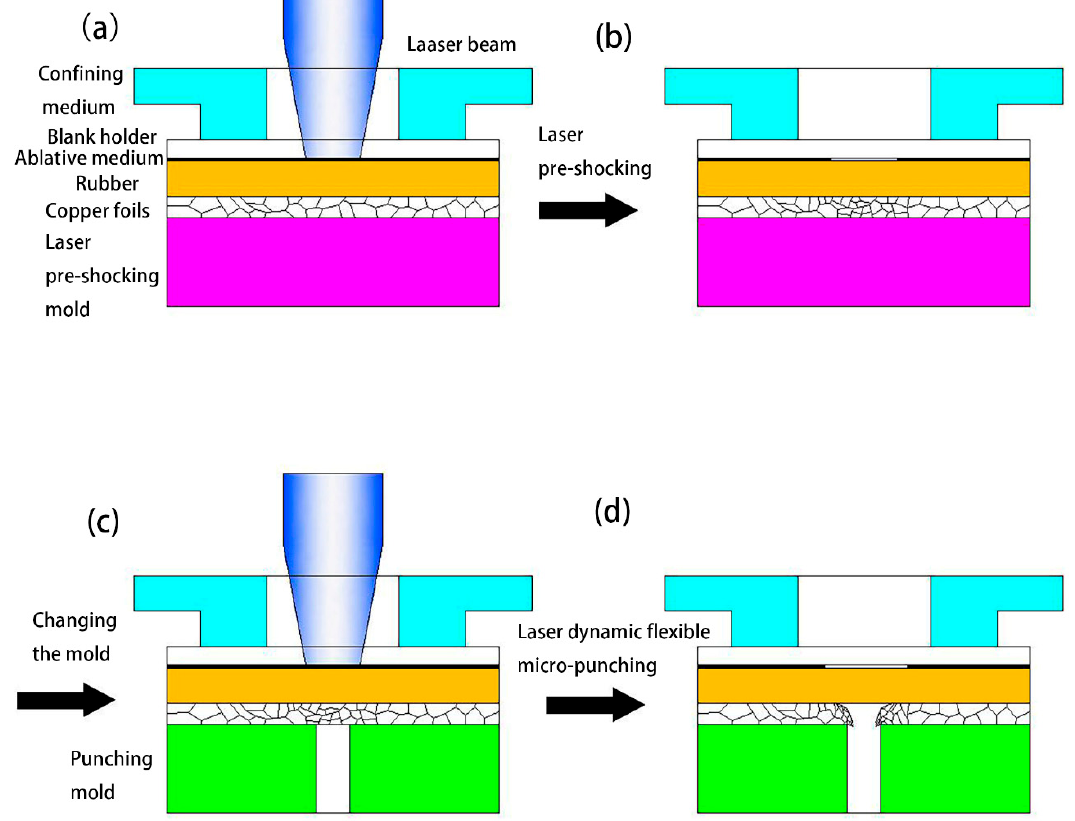
Figure 2. Process of laser dynamic flexible micropunching without laser pre-shocking (LPS). ( a ) Before laser dynamic flexible micropunching; ( b ) After laser dynamic flexible micropunching.